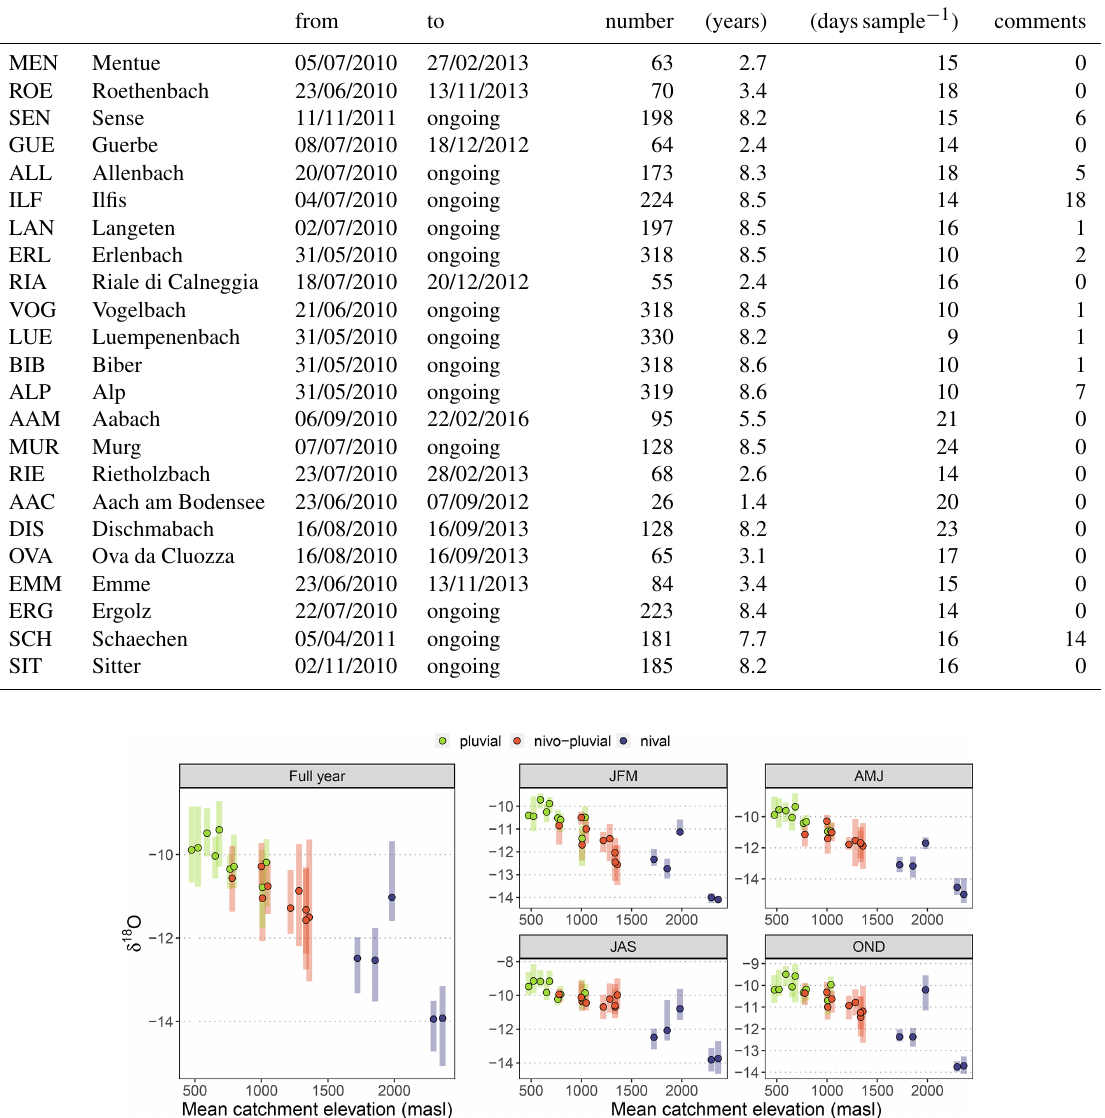
Table 2. Inventory of the data availability per catchment. ID